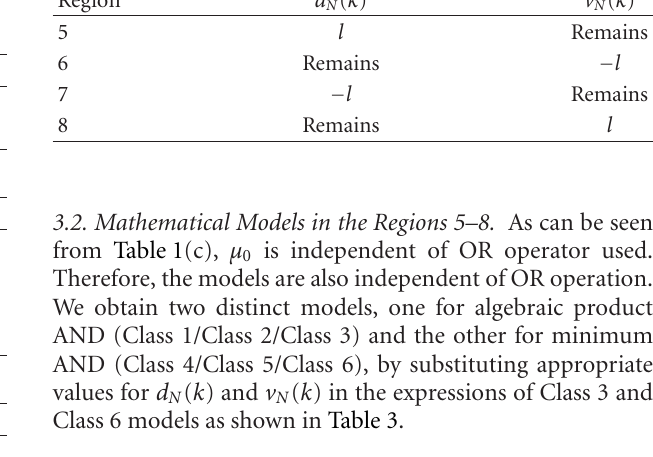
Table 2: (a) Signs of s 1 and s 2 . (b) Signs of s 1 , s 2 and s 3 . (c) Attributes of s 1 , s 2 , and x N ( k ).